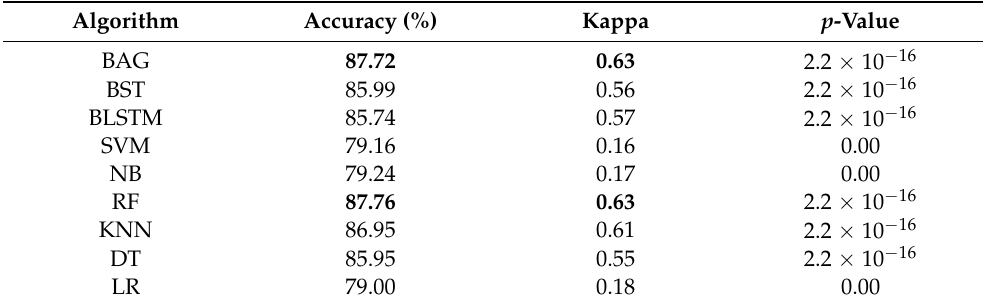
Table 9. Performance of CNN on BAG, BST, BLSTM, SVM, NB, RF, KNN, DT, and LR. The best results are shown in